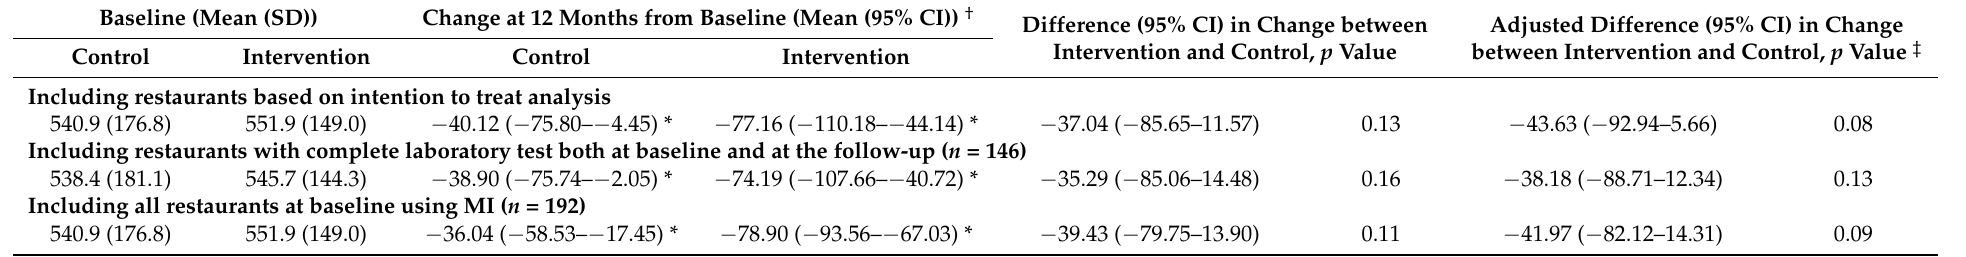
Table 2. Sodium content of restaurant dishes by laboratory test (mg/100 g).